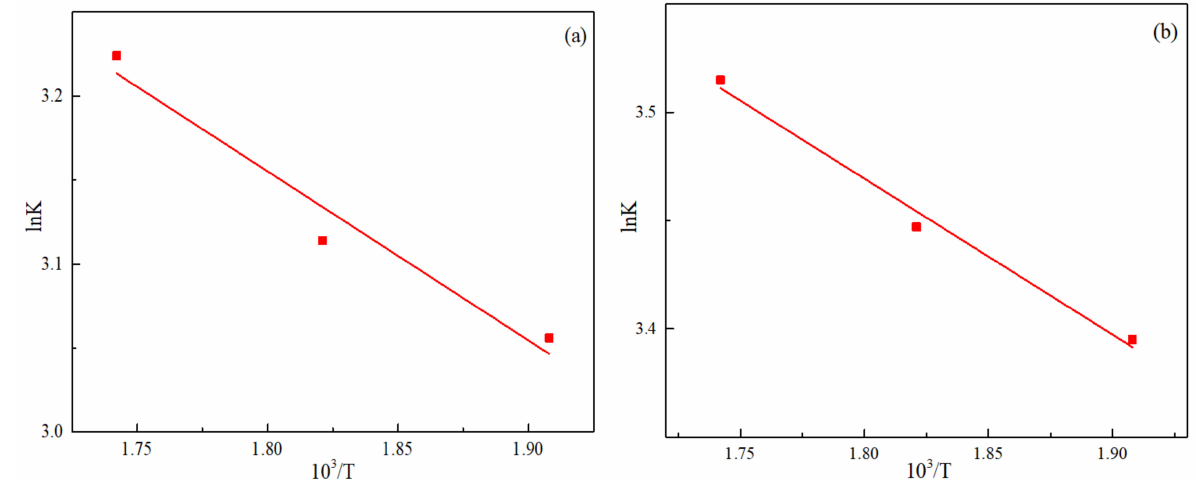
Figure 7. The relationship of lnK and 10 3 /T ( a ) SOC, ( b )